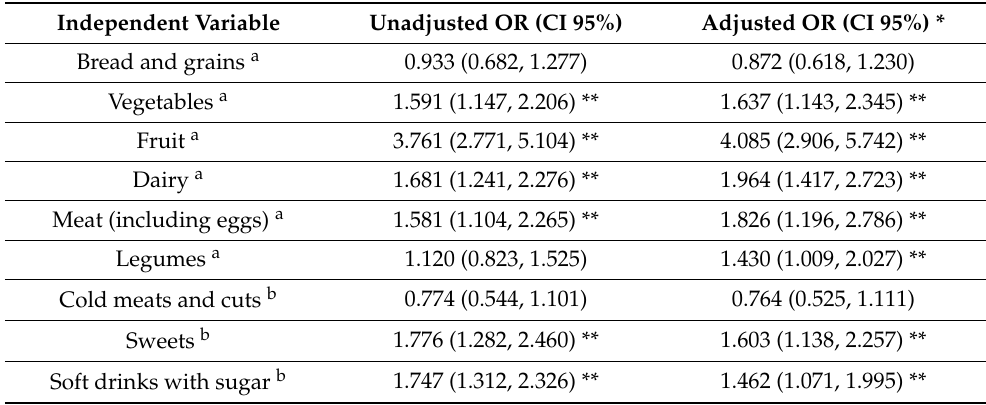
Table 4. Relationship between not adhering to national guidelines for consuming different foods and the presence of poor sleep quality (PSQI score >